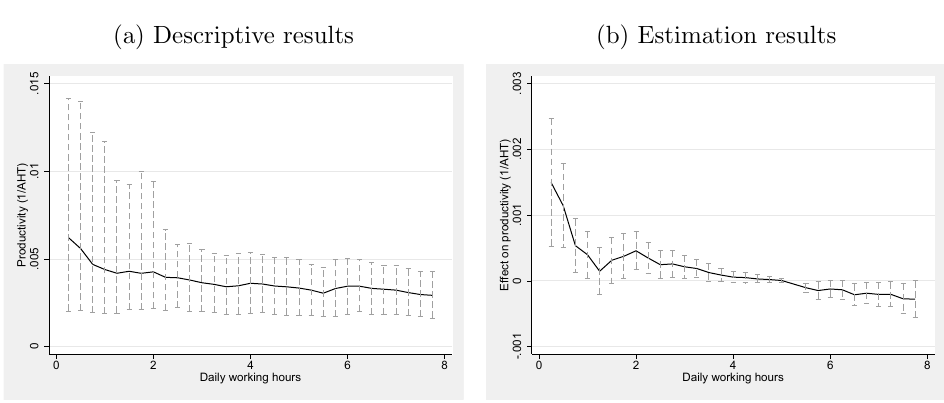
Figure 2: Productivity by working